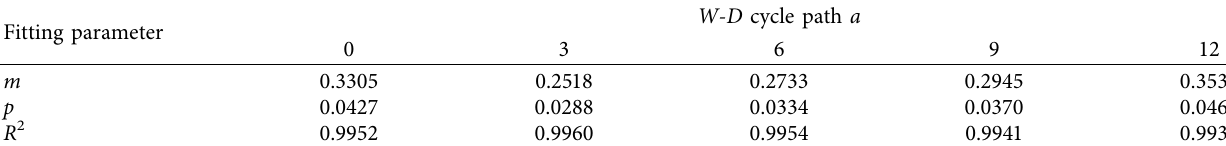
d of W - D cycle path d